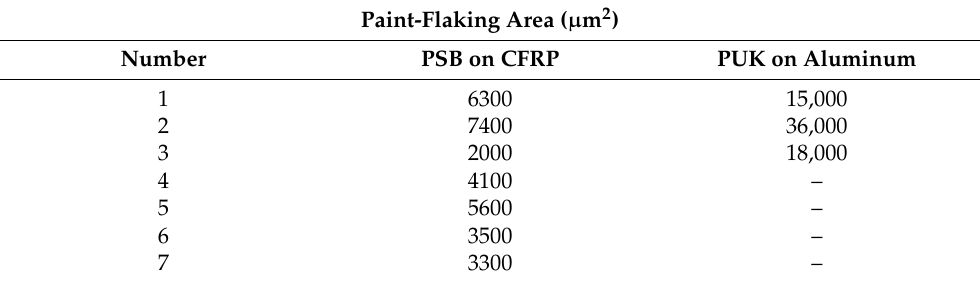
Table 10. Area of the flakes in both